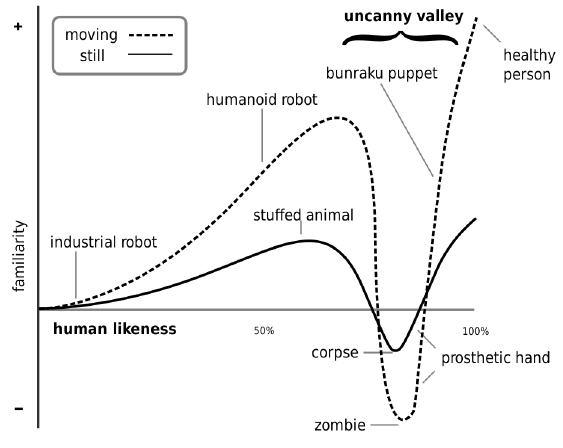
Figure 2. Uncanny Valley